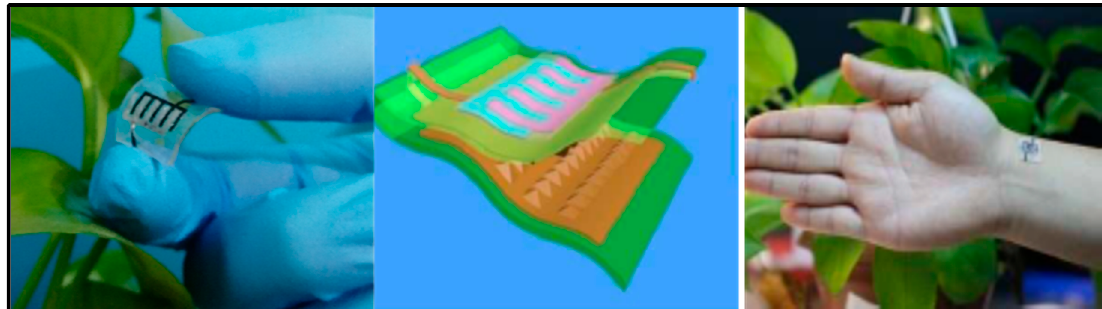
Figure 4. Optical photographs of a microbattery-pressure sensor system for pulse detection. Schematic diagram of the microbattery-pressure sensor system (center). Reproduced with permission from [219]. Copyright 2018 Royal Society of Chemistry.